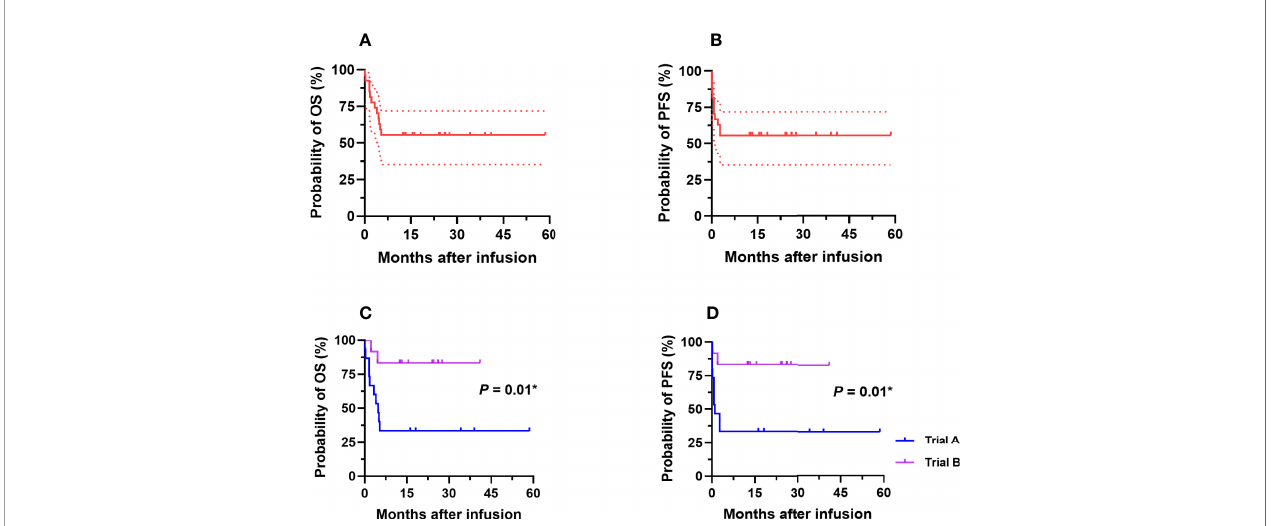
FIGURE 2 | Probabilities of OS and PFS of adult patients with r/r Burkitt lymphoma enrolled in our study. (A, B) The estimated 1-year PFS and OS of all participants were 55.6% (95%CI: 35.2 – 71.8%) and 55.6% (95% CI: 35.2% – 71.8%), respectively. (C, D) The estimated 1-year PFS rates of the patients in trial A and trial B were 33.3% (95% CI: 12.1% – 56.4%) and 83.3% (95% CI: 48.2% – 95.6%), respectively ( p = 0.01), which were the same as the 1-year OS rates. OS, overall survival; PFS, progression-free survival; r/r, refractory/relapsed. *The comparison was considered statistically signi fi